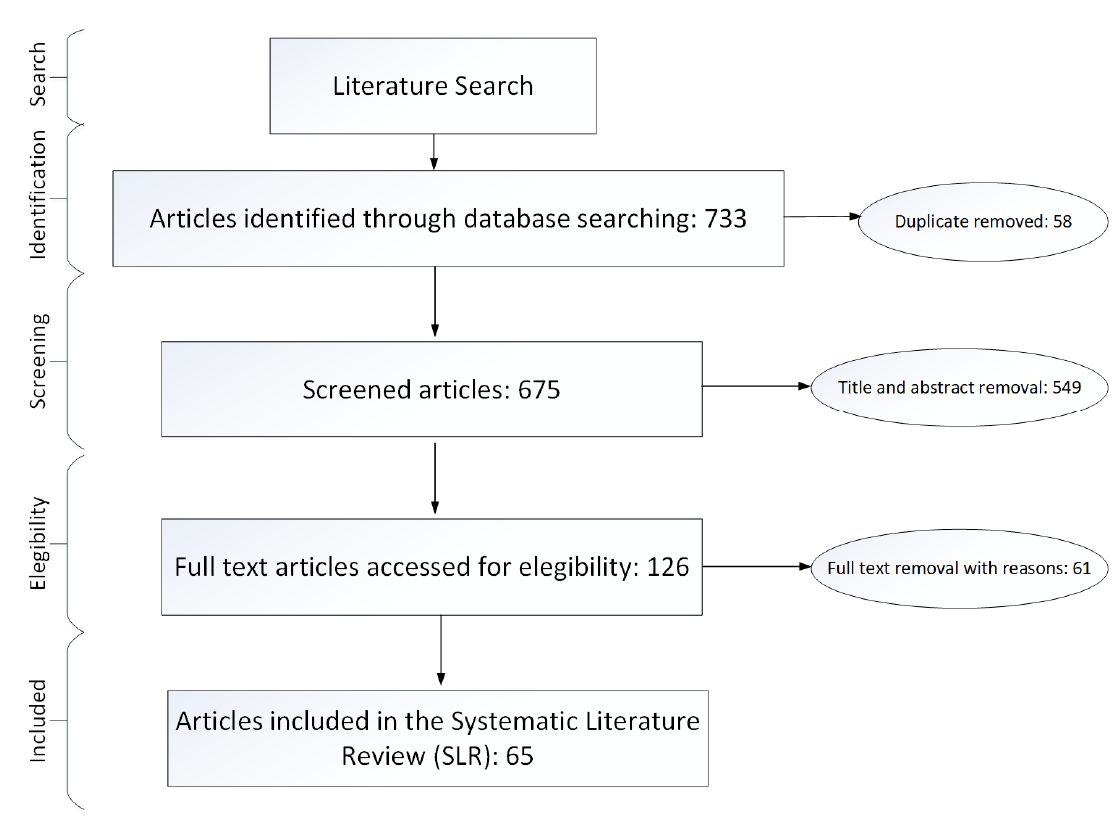
Figure 1. Literature search flow diagram.